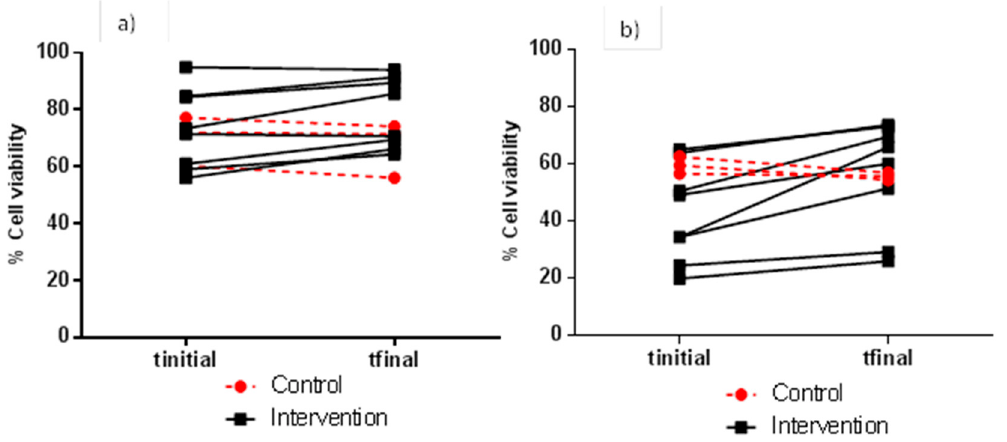
Figure 3. Individual evolution of viability (% with respect to the control) of HCT 116 cells after exposure to FW from the control and intervention groups. Cytotoxicity assay conditions: 1:5 ( v / v ) for FW dilution, and 4 h ( a ) and 24 h ( b ) for incubation time.